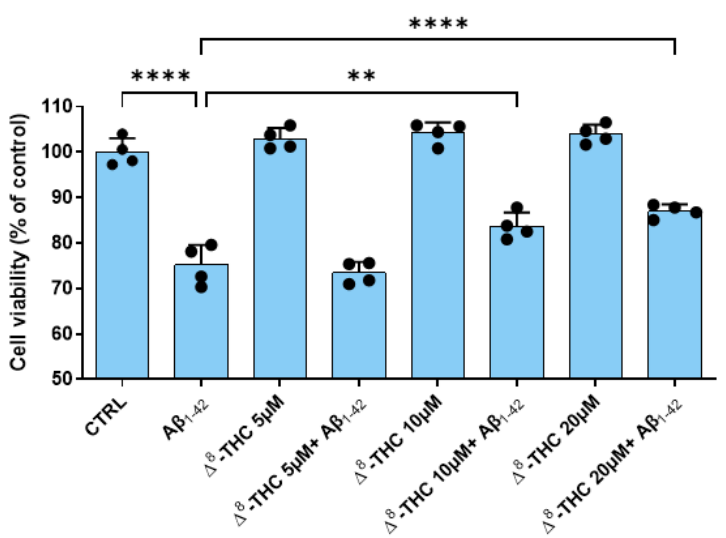
Figure 1. Cell viability after Aβ 1-42 and Δ 8 -THC treatment. The treatment with 10 µM Aβ 1-42 reduced cell viability of RA-differentiated SH-SY5Y cells, but Δ 8 -THC pretreatment at the concentrations 10 and 20µM was able to restore cell viability. N = 4 independent experiments. The results are ex- pressed by mean ± standard deviation (SD). ** p < 0.01; **** p <